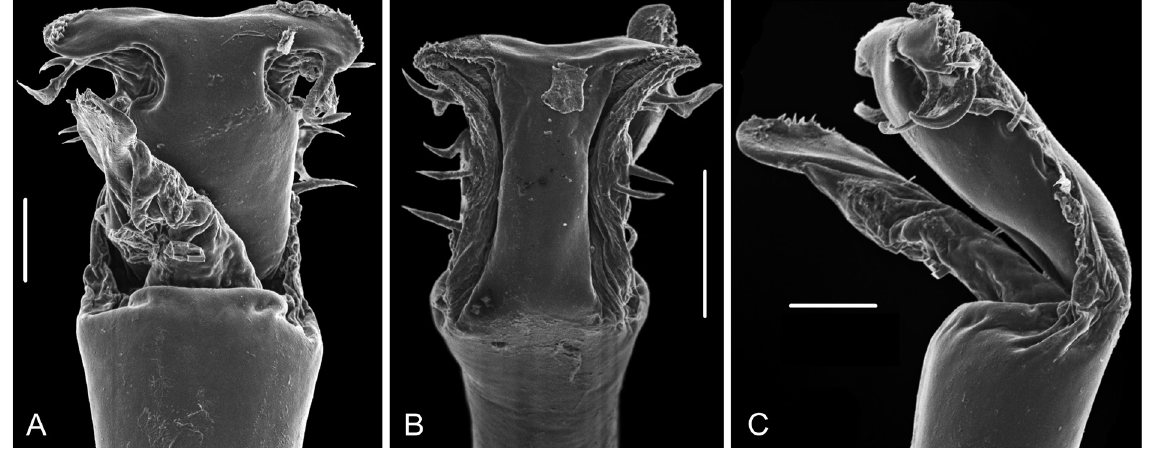
Fig. 14. Eulibitia helena sp. nov., ♂, paratype (IAvH 38). A . Distal view of penis, dorsal view. B . Same, ventral view. C . Same, lateral view. Scale bars: A, C = 50 µm; B = 100